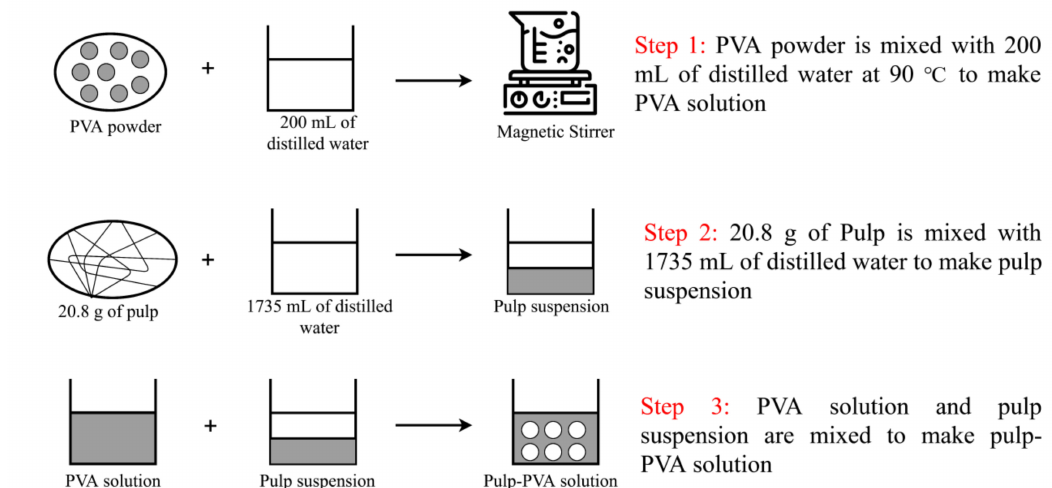
Figure 6. Polyvinyl alcohol (PVA) treatment on the Kenaf pulps.